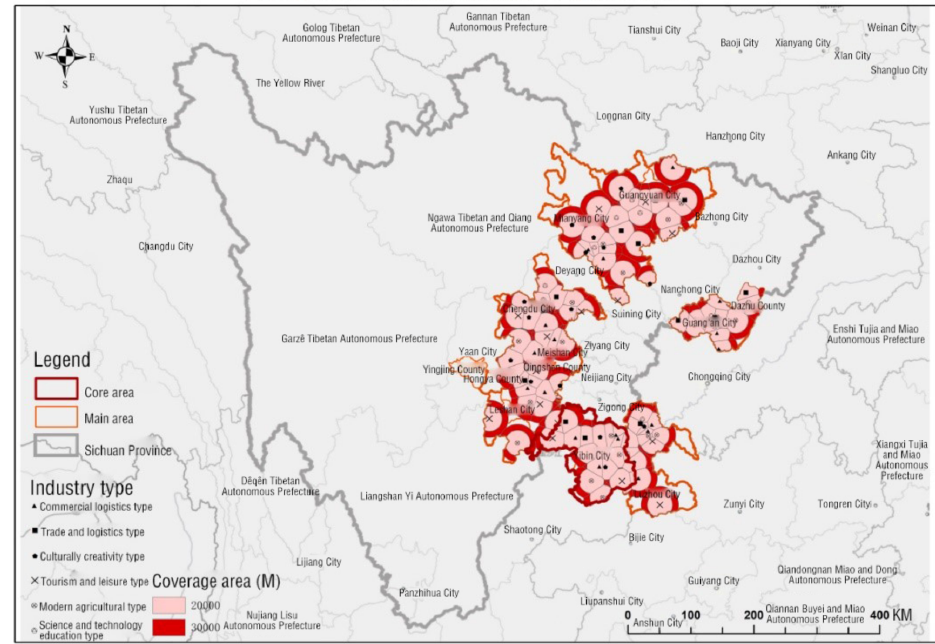
Figure 22. Cover of characteristic towns in research areas of Sichuan Province.